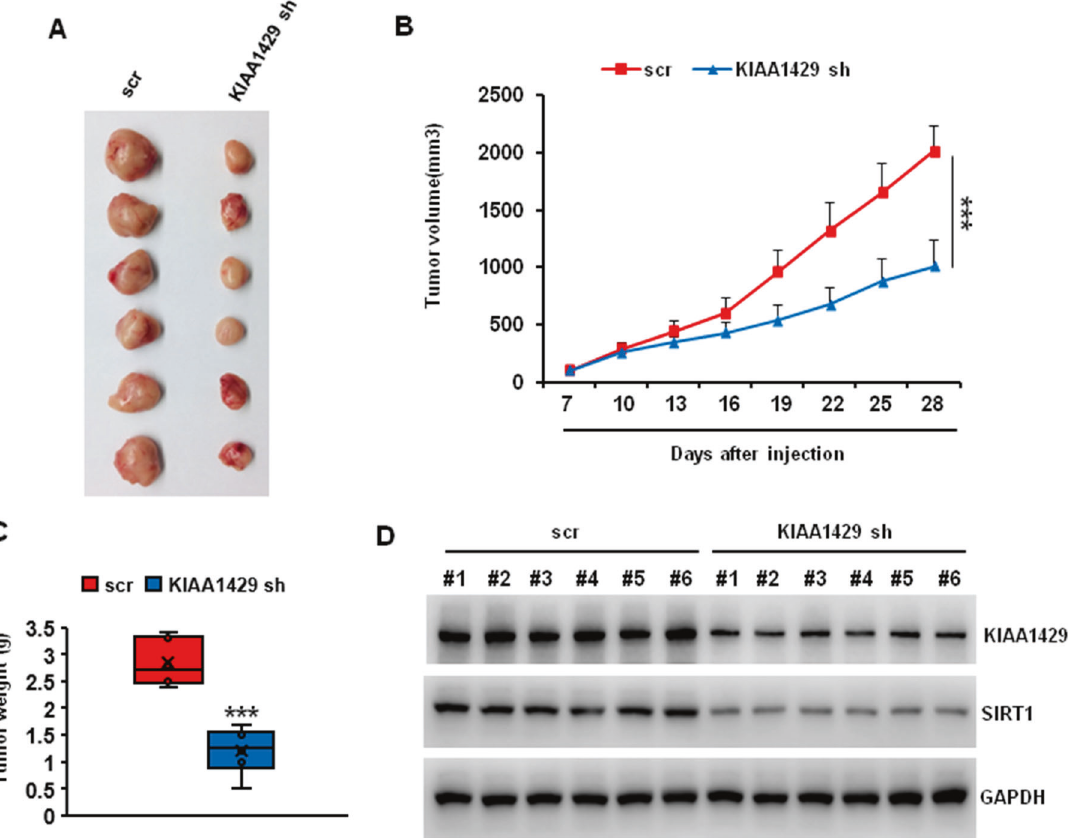
Fig. 7 Effects of METTL3 depletion on tumor growth in vivo. A Typical photos of tumors on day 28 from scr and KIAA1429 shRNA groups. B , C KIAA1429 depletion signi fi cantly decreased the tumor size ( B ) and weight ( C ). *** P < 0.001. D Protein levels of KIAA1429 and SIRT1 in six representative tumors from each group were analyzed by western blotting.